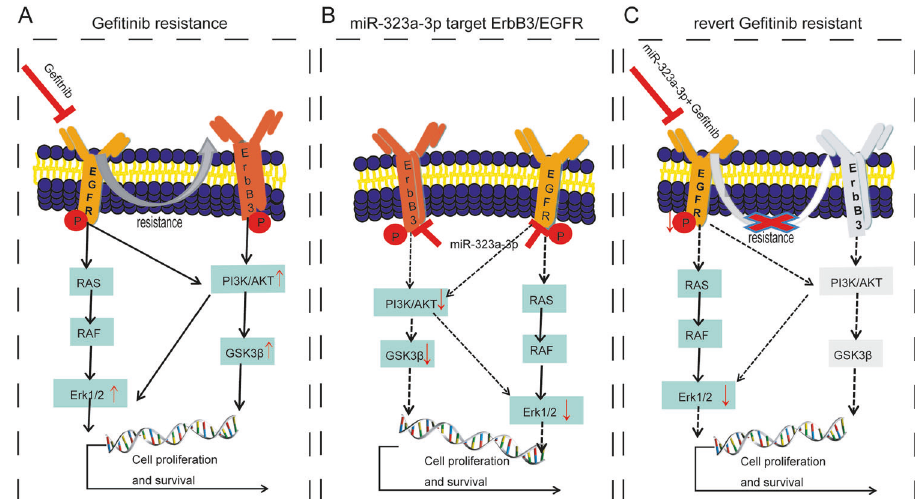
Fig. 7 MiR-323a-3p inhibits ge fi tinib resistance acquisition by targeting ErbB3/PI3K/Akt-EGFR/Erk1/2 signaling in colorectal cancer. A Erbb3/EGFR pathway is activated in ge fi tinib resistance CRC cells. B MiR-323a-3p inhibits phosphorylation of Erk1/2-PI3K/Akt/GSK3 β by targeting ErbB3/EGFR directly. C MiR-323a-3p blocks acquired ge fi tinib resistance by targeting ErbB3/PI3K/Akt-EGFR/Erk1/2